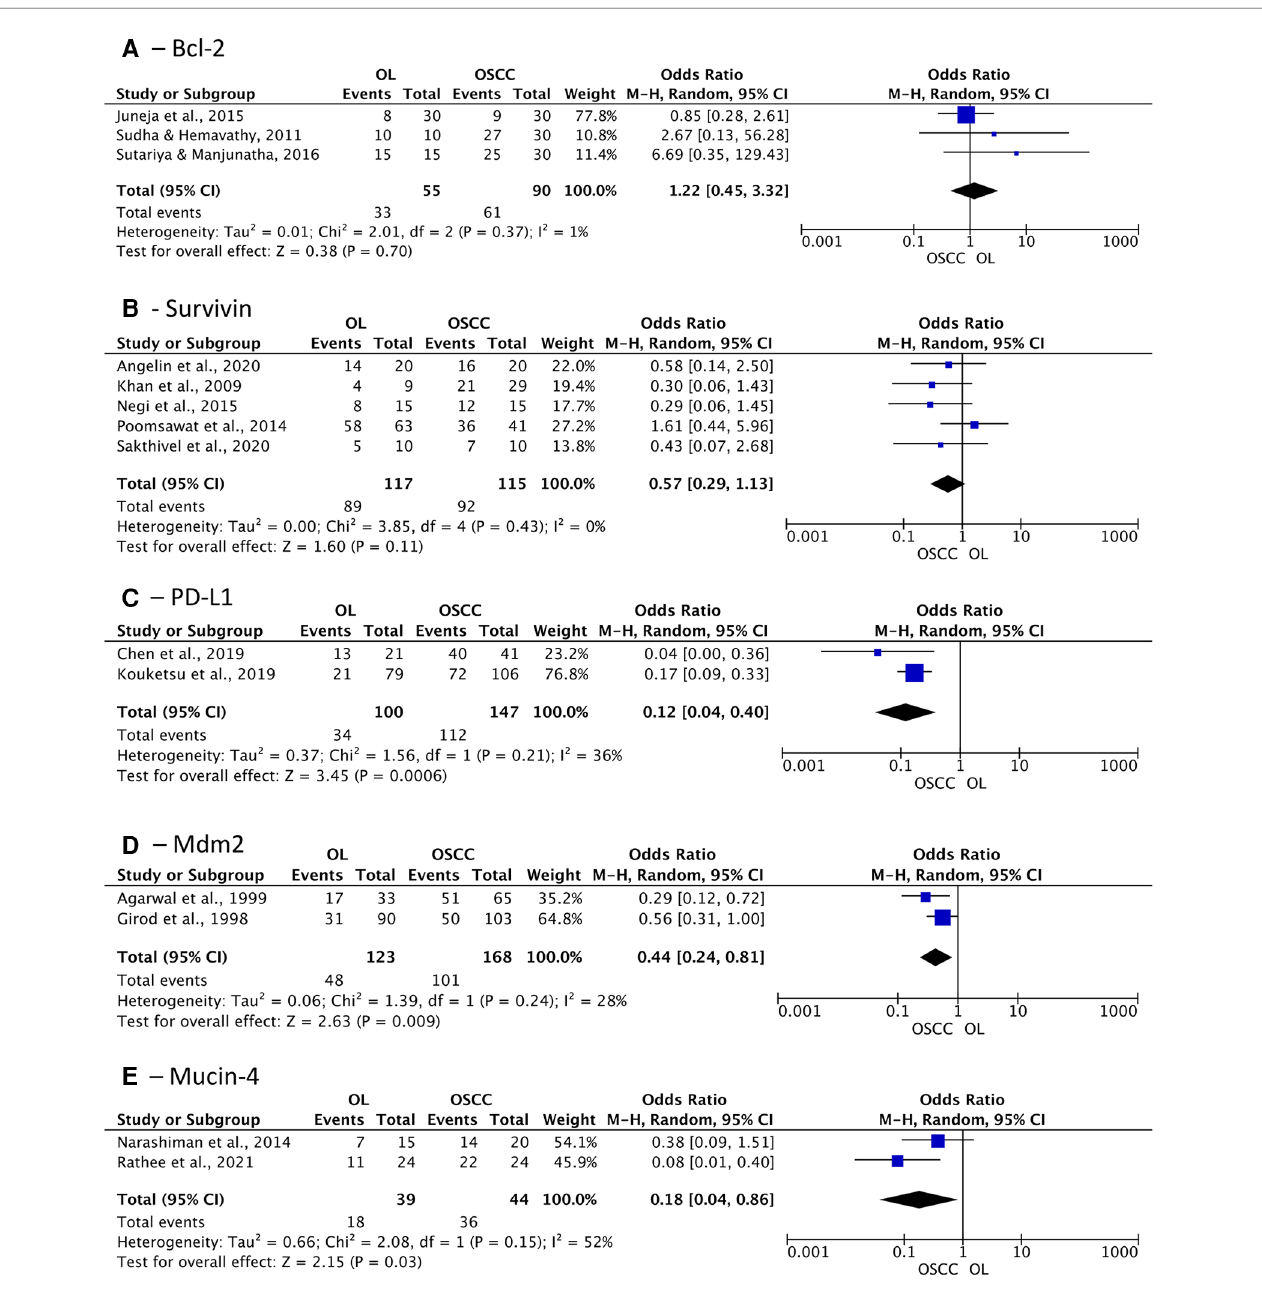
FIGURE 5 Association of expression of apoptosis suppressor proteins and tumor progression related proteins in oral leukoplakia (OL) compared to oral squamous cell carcinoma (OSCC). ( A ) Bcl-2; ( B ) Survivin; ( C ) PD-L1; ( D ) Mdm2; ( E )